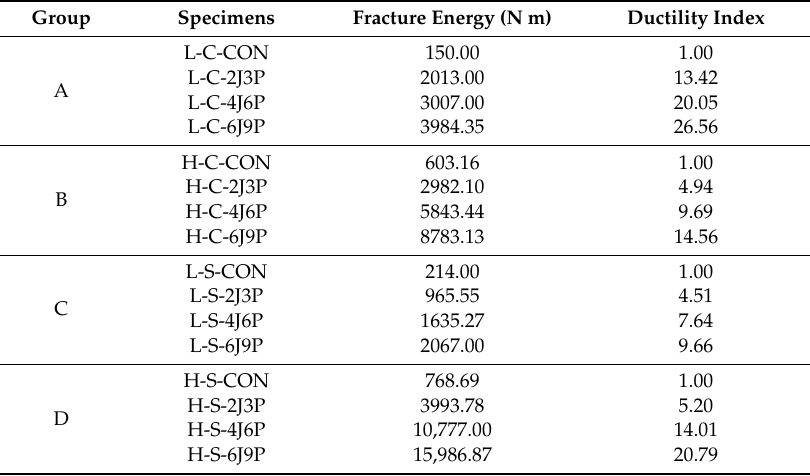
Figure 12. The area under the load-displacement curve obtained by OriginPro. Table 7. Average values of all tested